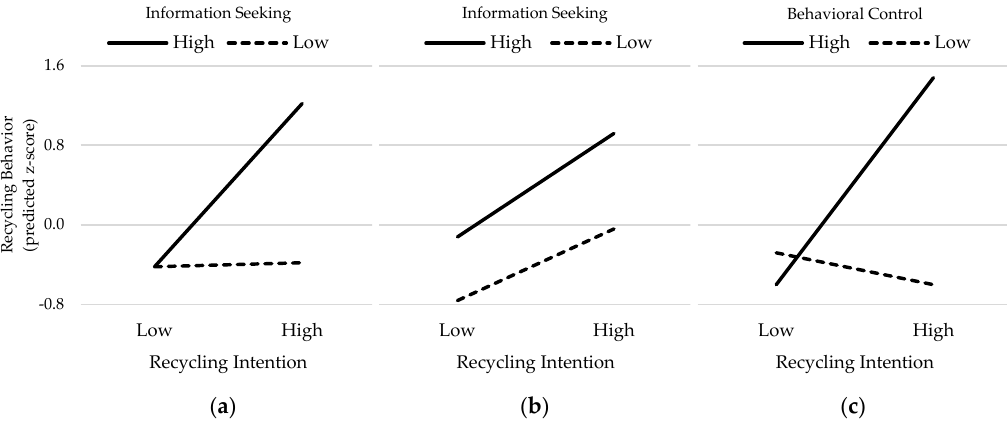
Figure 3. ( a ) The interaction of recycling intention and information seeking has a significant effect on recycling behavior. ( b ) That effect diminishes after modeling ( c ) the interaction of recycling intention and behavioral control. The high and low values of interacting variables are M ± 2 SD .